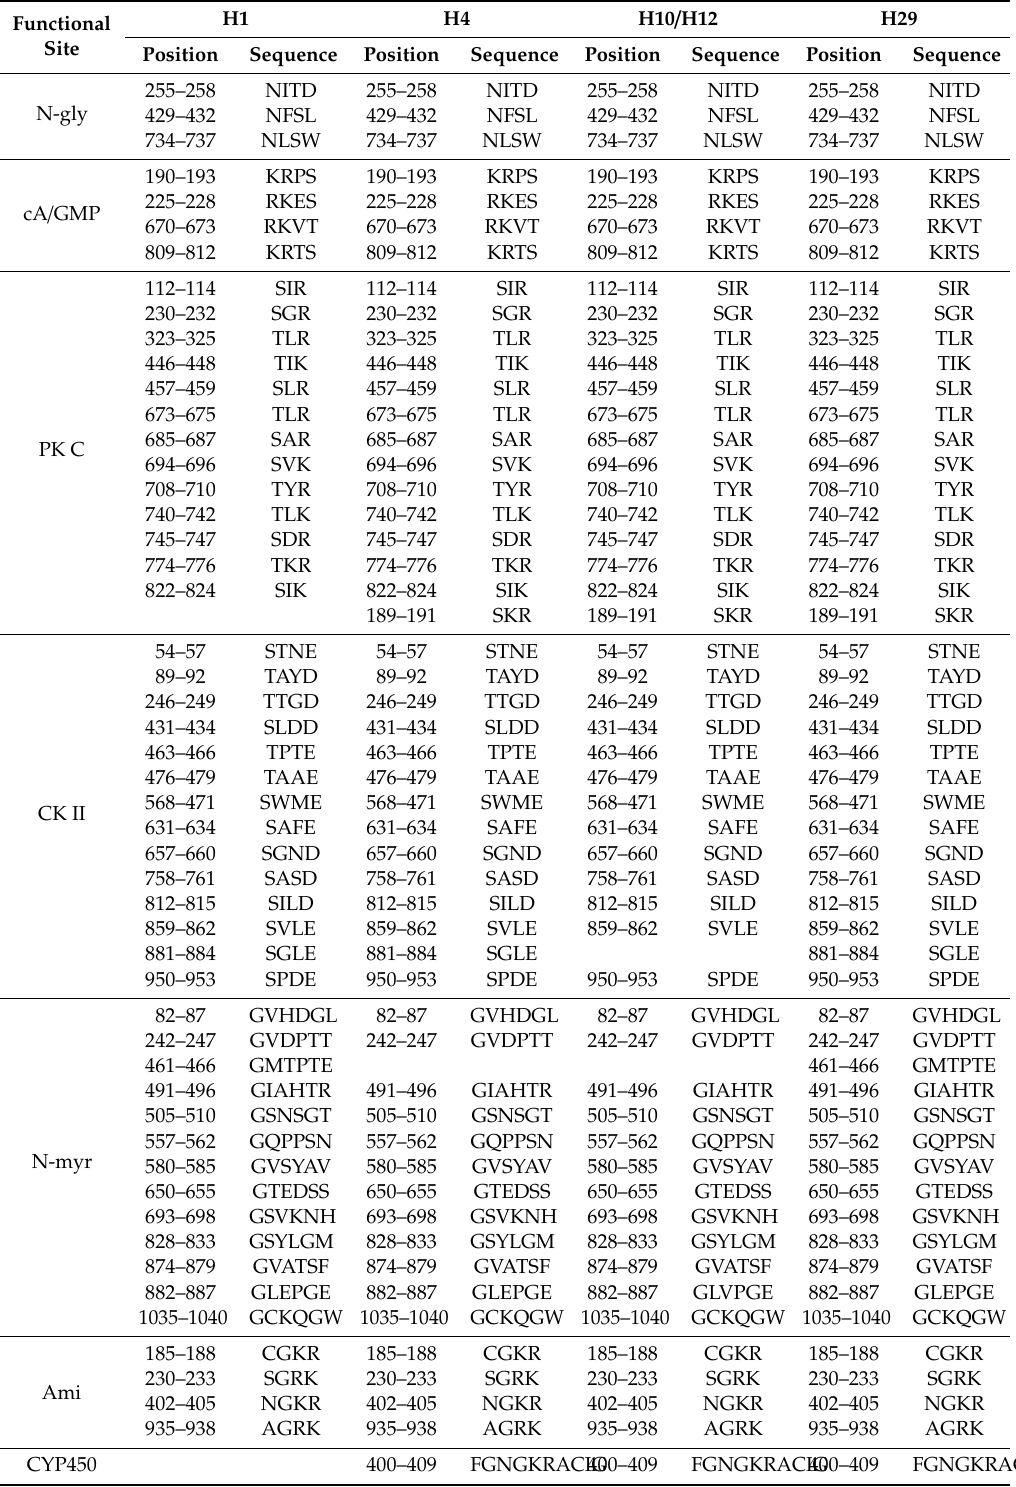
Table 4. Predicted protein motifs of NADPH-cytochrome P450 reductase-2 encoding by di ff erent haplotypes of O. sinensis